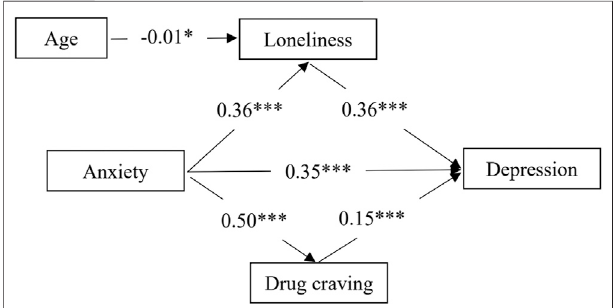
FIGURE 1 | Structural equation model (standardized coef fi cients). Notes . * p < 0.05; ** p < 0.01; *** p < 0.001.